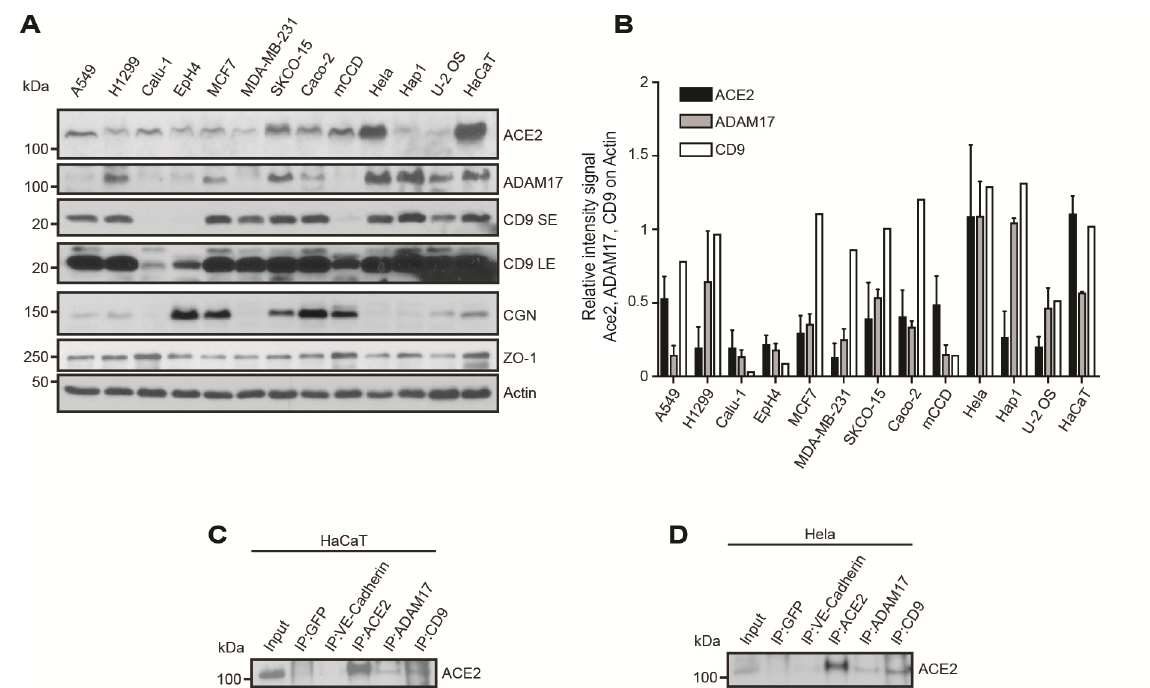
Figure 2. The ACE2 receptor is widely expressed in cultured cell lines and co-immunoprecipitates with ADAM17 and CD9 in lysates of HaCaT and HeLa epithelial cells. ( A , B ) Immunoblot (IB) analysis ( A ) and quantification ( B ) ( n = 2 except for CD9, n = 1) of the expression of ACE2, ADAM17 and CD9 in lung epithelial/lung cancer cells (A549, H1299, Calu-I), mammary epithelial (Eph4) and breast adenocarcinoma cells (MCF7, MDA-MB-231), colon adenocarcinoma cells (SKCO-15, Caco-2), kidney collecting duct cells (mCCD), uterine cervical cancer cells (HeLa), myeloblastic haploid cells (Hap1), osteosarcoma cells (U-2 OS), and immortalized keratinocytes (HaCat). IBs for CGN (cingulin) and ZO-1, which are cytoplasmic proteins of tight junction (TJ) (CGN and ZO-1) and adherens junctions (ZO-1), are also shown. IB of actin is shown for the normalization of protein levels. Numbers on the left indicate approximate molecular sizes, based on the migration of prestained markers. SE and LE refer to Short Exposure and Long Exposure, respectively, for CD9. ( C , D ) Immunoblot analysis of endogenous ACE2 SARS-CoV-2 receptor (ACE2) in immunoprecipitates (IPs) obtained from lysates of HaCat ( B ) and HeLa ( C ) cells, using the indicated antibodies. Note that ACE2 is detected in IPs of ADAM17 and CD9. Ips obtained using antibodies against GFP and VE-cadherin are negative controls, and IP:ACE2 is a positive